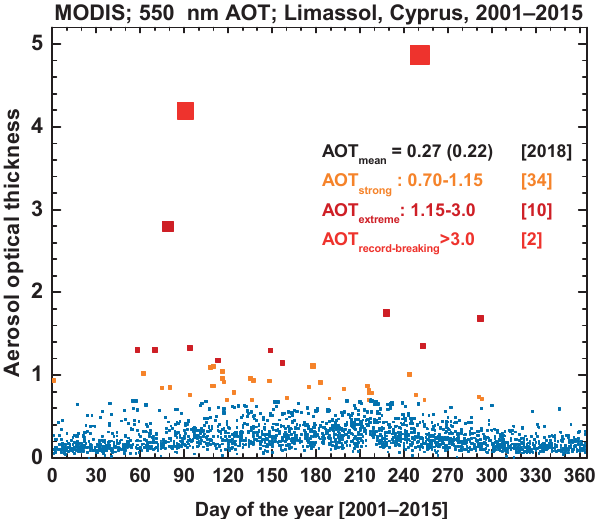
Figure 1. Seasonal distribution of 550nm AOT at Limassol, based on 15 years of MODIS observations (http://lance-modis.eosdis. nasa.gov/, terra MODIS, 2001–2002, aqua MODIS, 2003–2015). The mean AOT for an area centered at Limassol with a 25km ra- dius is shown. Numbers (in black) indicate the 15 year mean AOT (M), the standard deviation (SD, in parentheses), and the total num- ber of considered daily observations (in brackets). The numbers of strong dust events (AOT from M + 2SD to M + 4SD), of extreme dust events (AOT from M + 4SD to 3.0), and record-breaking dust events (AOT > 3) are given in orange, dark red, and red, respec- tively. MODIS collection-6 data were used for the years 2005–2015 and collection-51 data for 2001–2004. More details to the MODIS data, including AOT retrieval uncertainties, are given in Sect.